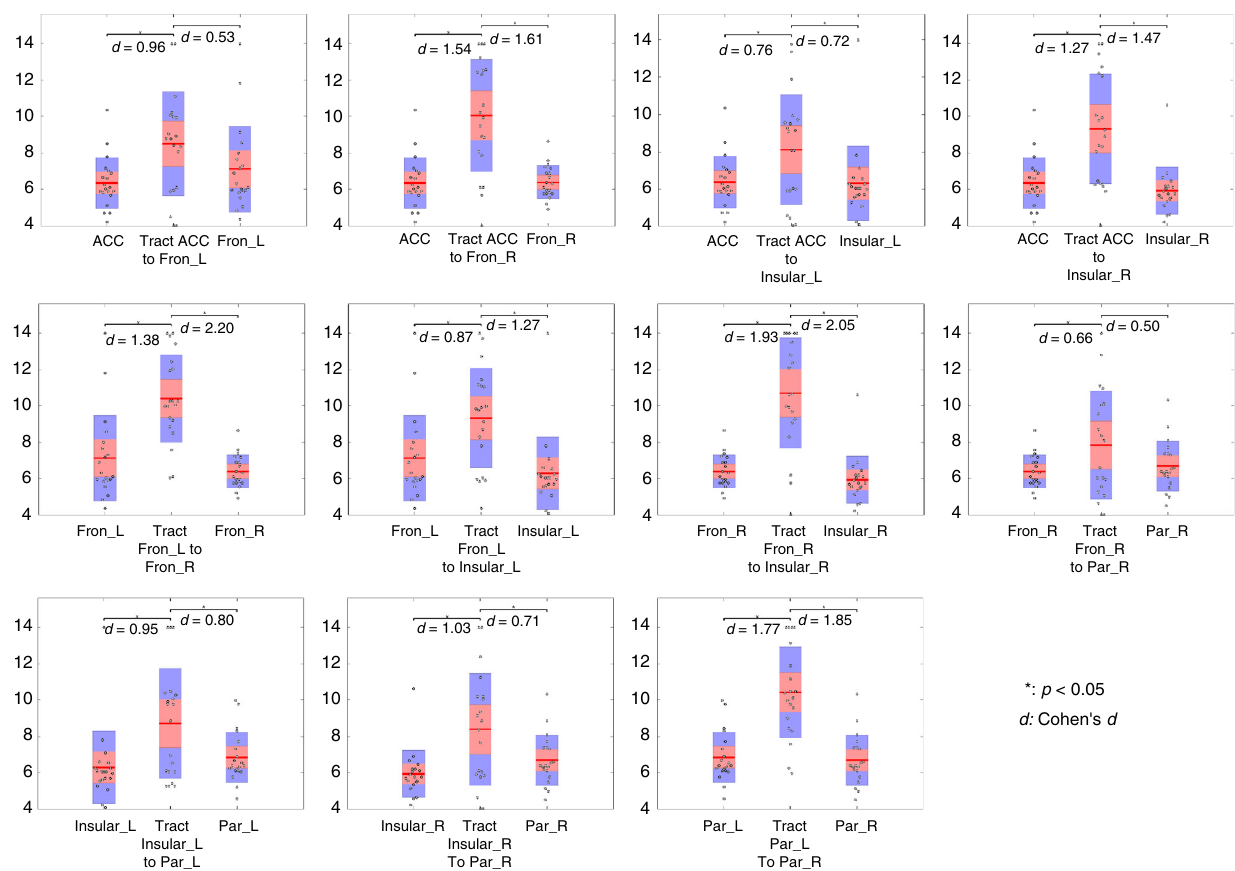
Fig. 4 Average TTPs of WM tracts and their connecting GM clusters. Average TPP of one WM tract was displayed in the center of each panel with the average TTP of its connecting GM clusters on either side. The y -axis is the TTP (seconds). Points are laid over a 1.96 SEM (95% con fi dence interval) in red, a 1 SD in blue and a center line that denotes the median. 9 of 11 tracts showed signi fi cantly longer time ( P < 0.05, t -test) to reach the peak in comparison with their connecting GM clusters. Source data are provided as a Source Data fi